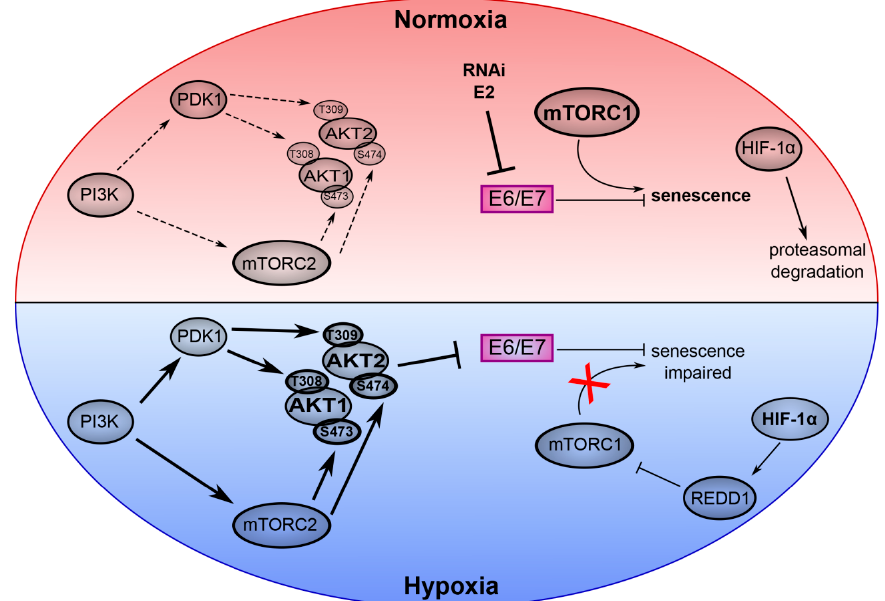
Figure 2. Key role of the PI3K / AKT / mTOR network in the virus / host cell crosstalk in HPV-positive cancer cells under normoxia and hypoxia. The upper part of the model (red) depicts normoxic HPV-positive cancer cells. Here, experimental inhibition of E6 / E7 expression by RNA interference (RNAi) or expression of HPV E2 e ffi ciently induces senescence dependent on active mTORC1 signaling. HIF-1 α is degraded by the proteasome. The lower part of the model (blue) represents hypoxic HPV-positive cancer cells. Phosphorylation of AKT1 and AKT2 is induced by their canonical upstream regulators PI3K, mTORC2 and PDK1. Hypoxic activation of AKT mediates repression of E6 / E7. Hypoxia also leads to the stabilization of HIF-1 α , which activates REDD1 and results in the inhibition of mTORC1. Thus, despite the AKT-mediated inhibition of E6 / E7, hypoxic HPV-positive cancer cells evade senescence due to impaired mTORC1 signaling. Arrows indicate an activation, bar-headed lines indicate an inhibition. (Copyright © American Society for Microbiology, (mBIO, 10(1), e02323–e02318, 2019 [25]).